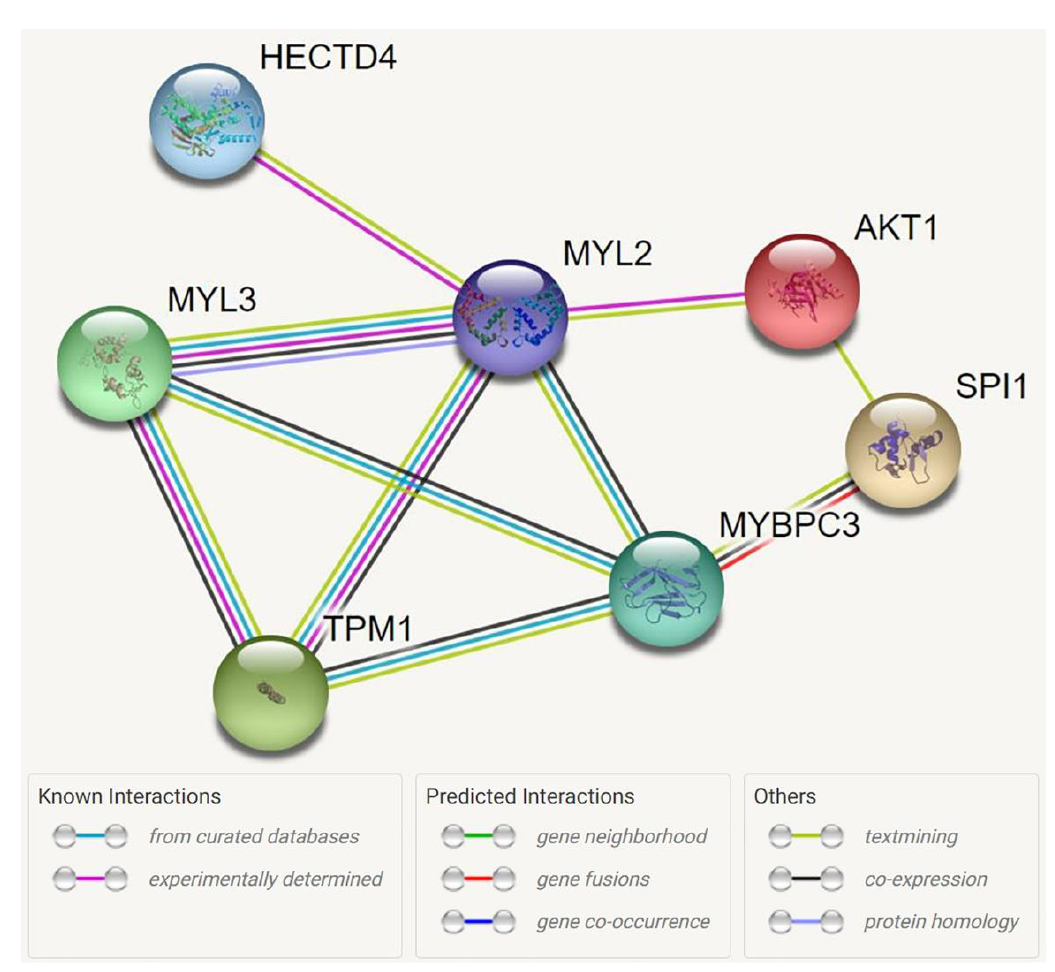
Figure 5. Network analysis of ApoA1. Table 5. Gene Ontology and KEGG pathway analyses of novel loci-related genes associated with ApoA1.